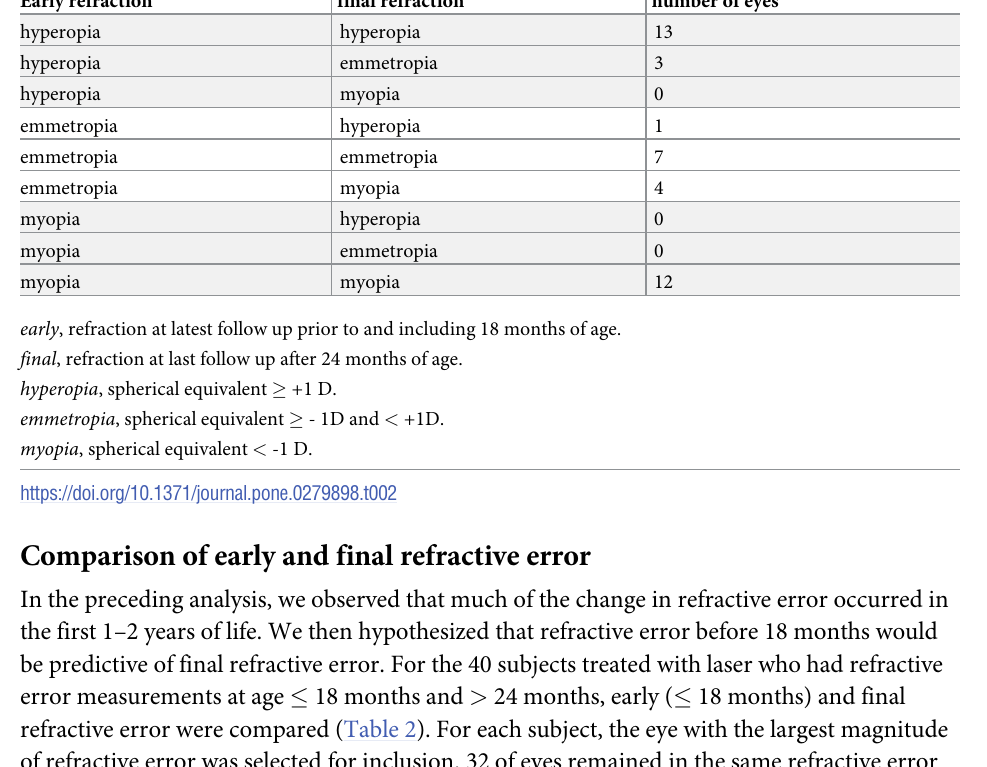
Table 2. Early refraction compared to final refraction for eyes that underwent laser treatment for retinopathy of prematurity.